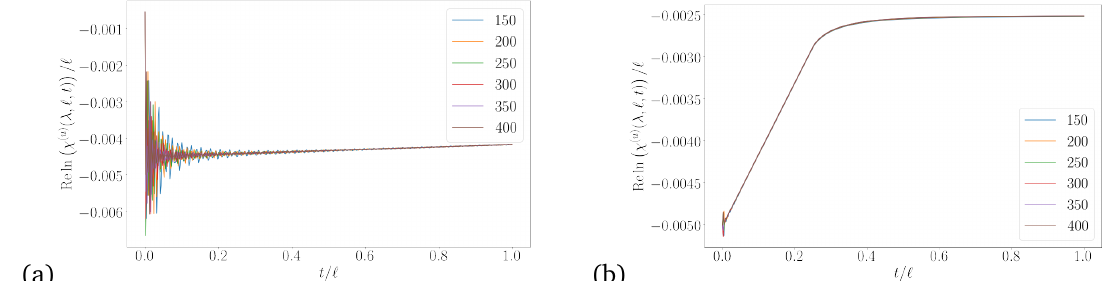
Figure 8: Reln χ ( u ) ( 0.1, (cid:96) , t ) /(cid:96) for several values of (cid:96) for a quench from (a) h = 3 to h = 0.2 and (b) h = 0 to h = 20. The data for different subsystem sizes are seen to collapse at sufficiently late times.